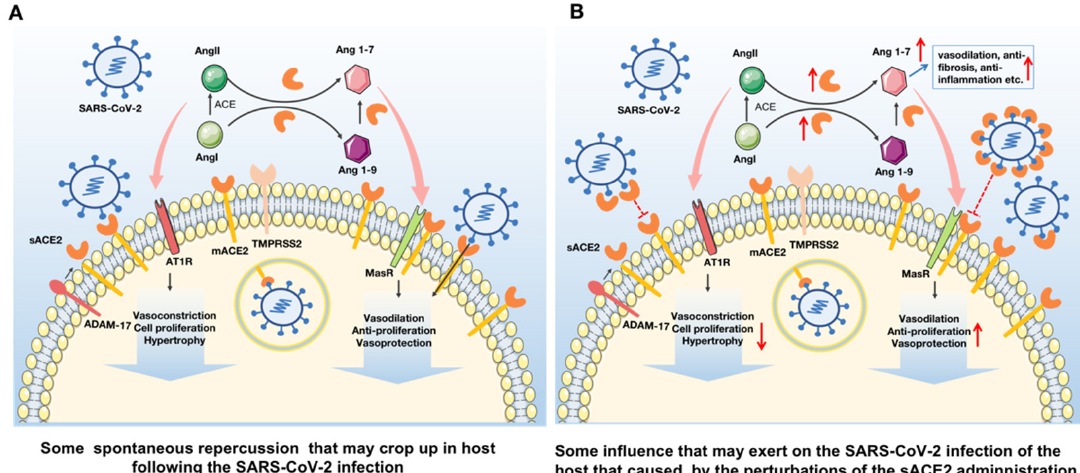
Figure 2. Administration of sACE2 in COVID-19 patients might play the function of killing two birds with one stone: a promising therapeutic strategy to treat both cardiovascular diseases and the SARS-CoV-2 infection. ( A ) Following the invasion of SARS-CoV-2, mACE2 will mediate its entry into host cells. Meanwhile, mACE2 and low concentrations of sACE2 in vivo will cleave Ang I and Ang II to form Ang 1-9 and Ang 1-7, respectively. Ang II promotes vasoconstriction, cell proliferation and hypertrophy by binding with AT1R while Ang1-7 promotes vasodilation, anti-cell proliferation and vasoprotection by binding with MasR. ( B ) With the administration of rsACE2, sACE2 level in vivo will increase, which will promote its binding to SARS-CoV-2 and inhibit the virus infection through blocking its further binding with mACE2. Besides, the increase of free sACE2 contributes to the further conversion of Ang I and Ang II into Ang1-9 and Ang1-7, which promotes vasodilation, anti-fibrosis and vasoprotection etc., through its effect on the RAS system. Therefore, the increase of sACE2 can not only prevent SARS-CoV-2 infection but also contribute to the treatment of cardiovascular diseases. In this picture, ADAM-17 represents a disintegrin and metalloproteinase-17; AT1R represents (Ang II)-angiotensin type 1 receptor; hACE2 represents human ACE2; TMPRSS2 represents transmembrane protease serine 2; MasR represents the Mas receptor; PD represents the N-terminal peptidase domain; and CLD represents the C-terminal collectrin-like domain. The upward red arrow represents up-regulation, and the downward represents down-regu- lation.